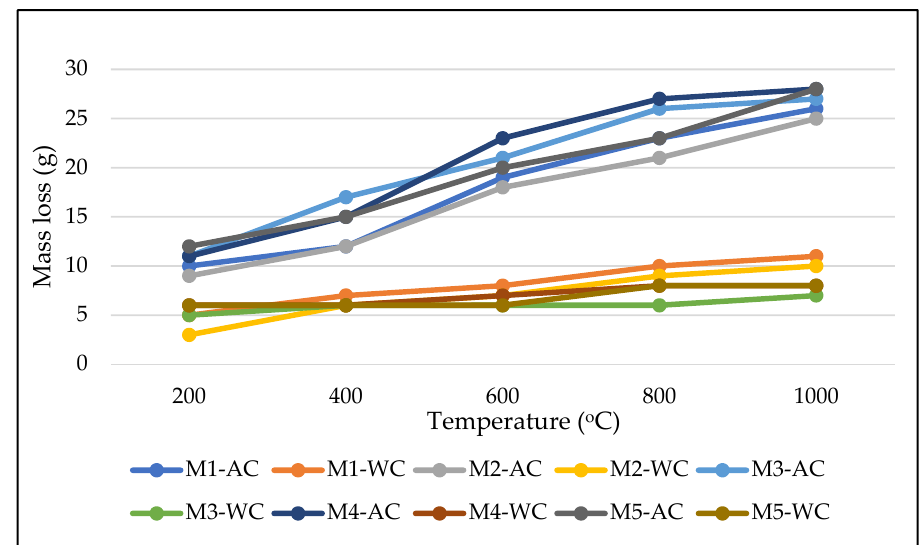
Figure 7. Mass loss of air-cured samples at elevated temperatures (where AC is air cooling, and WC is water cooling).